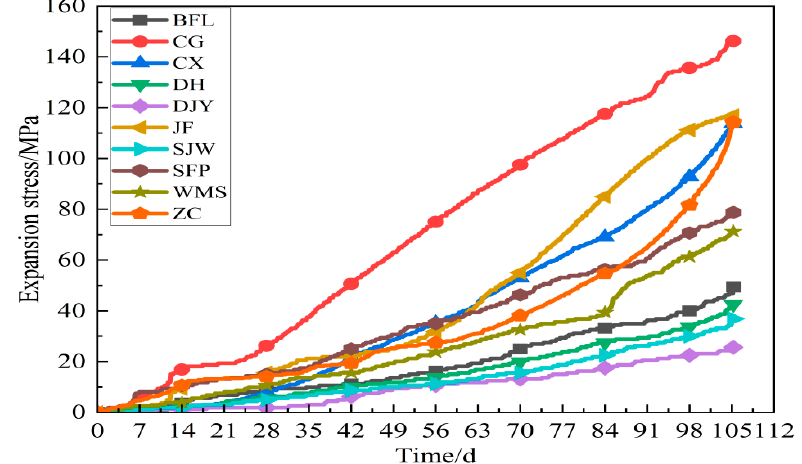
Figure 9. Expansion stress curve of compacted